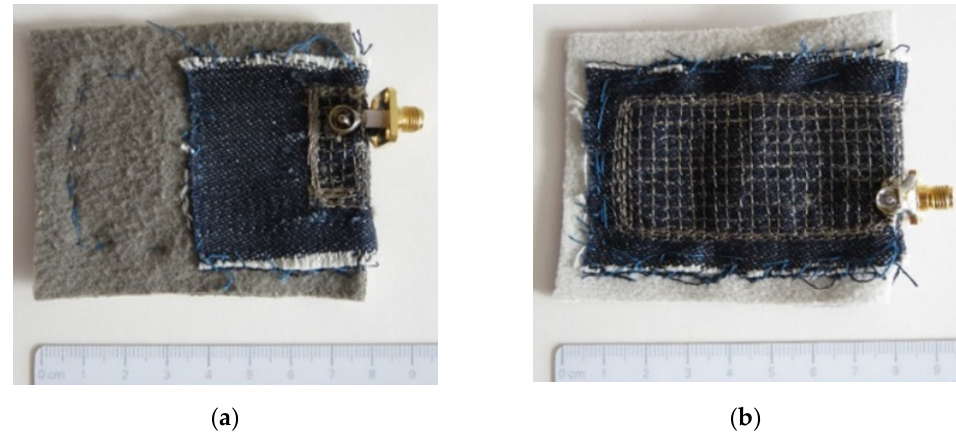
Figure 1. Side, top, and front view of the PIFA.